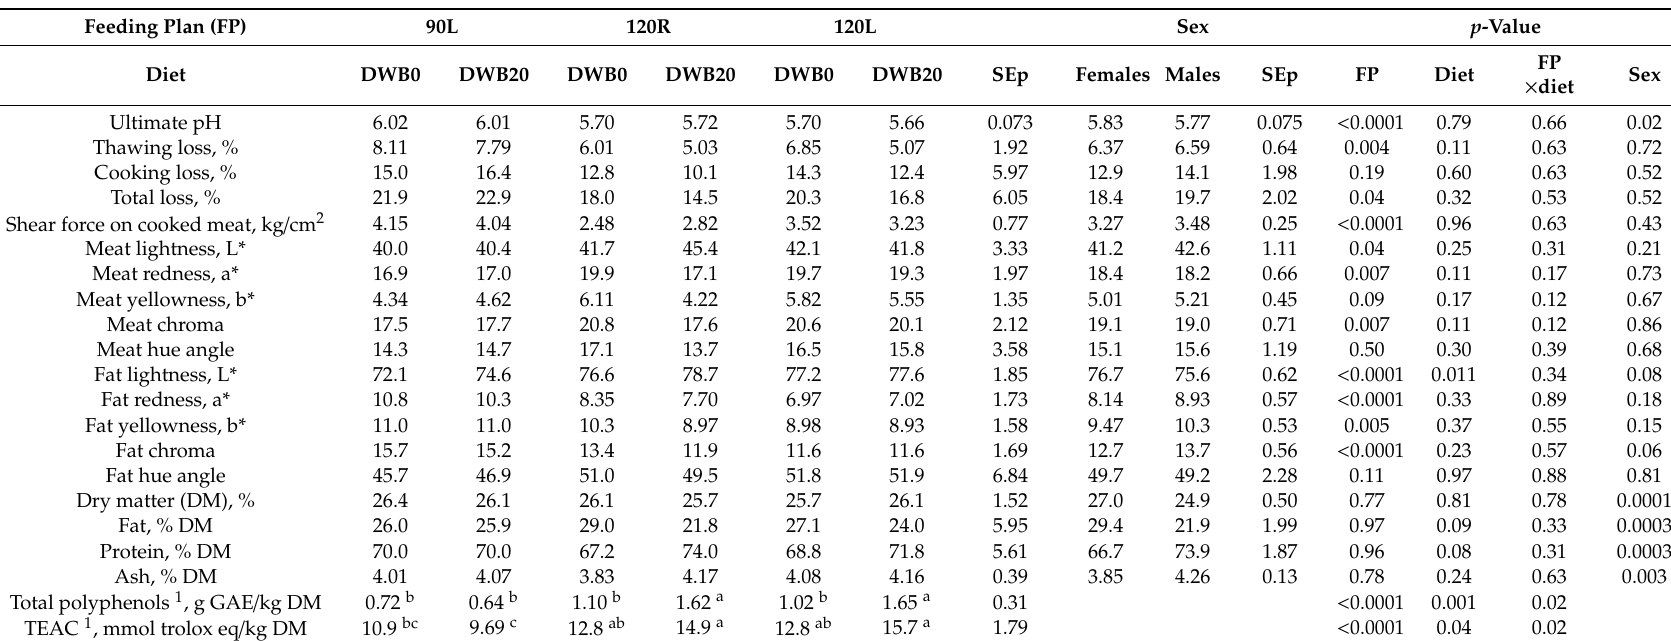
90L = ad libitum (L) feeding level from 45 to 90 days of lambs’ age. 120R, 120L = restricted (R) or ad libitum (L) feeding level from 90 to 120 days of lambs’ age. DWB0, DWB20 = concentrate with 0% or 20% of durum wheat bran. Sex: F = females, M = males. GAE = gallic acid equivalent. TEAC = Trolox equivalent antioxidant capacity. 1 On male lambs (n. 36). Sep = pooled standard error. On rows: a, b, c = p ≤